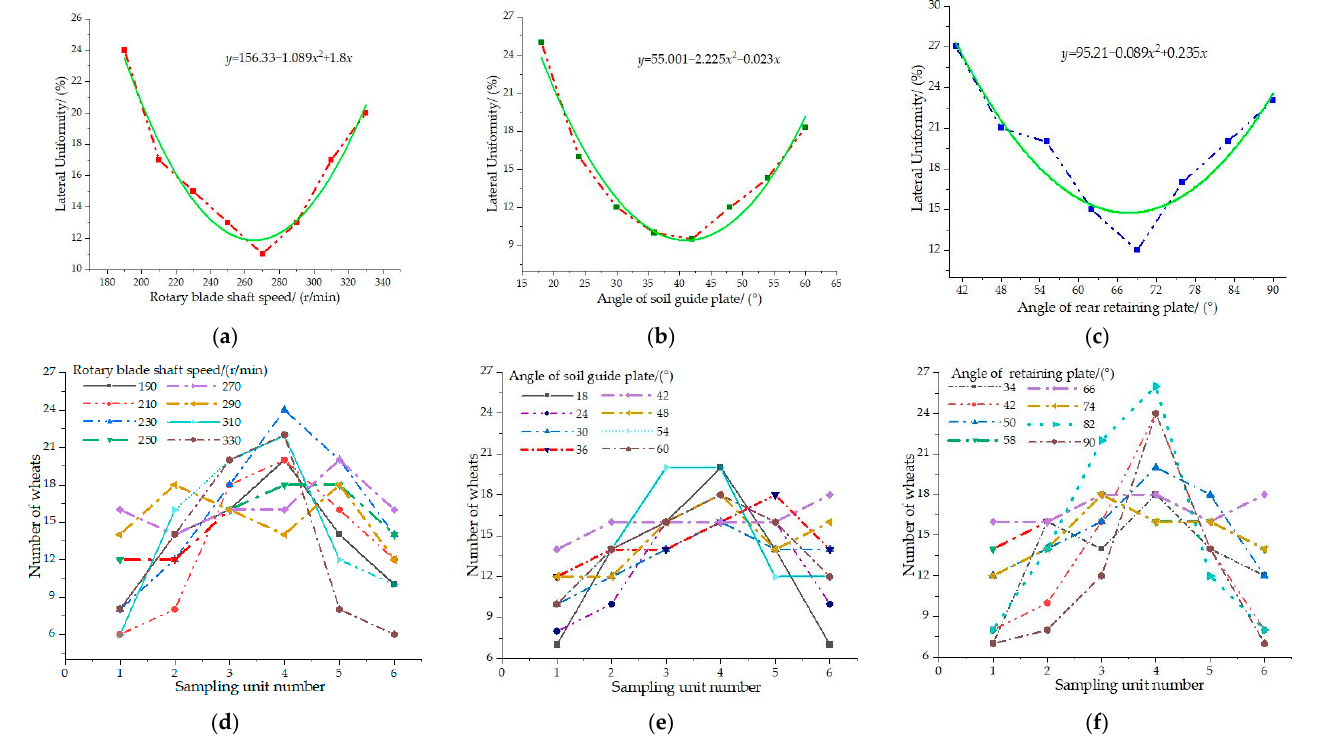
Figure 11. Single factor results of lateral uniformity. ( a ) The relationship between the rotation speed of rotary blade shaft and the lateral uniformity of wheat; ( b ) the relationship between the angle of the soil guide plate and the lateral uniformity of wheat; ( c ) the relationship between the angle of the soil-retaining plate and the lateral uniformity of wheat; ( d ) the relationship between the rotating speed of the rotary blade shaft and the number of seeds in each unit; ( e ) the relationship between angle of the soil guide plate and number of seeds in each unit; ( f ) the relationship between angle of the soil-retaining plate and number of seeds in each